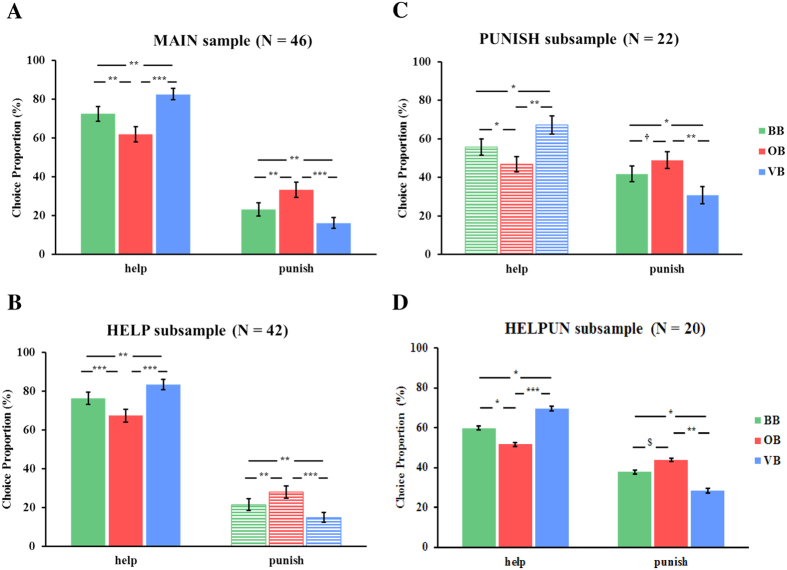
Proportion of altruistic choices in different other-regarding attention conditions.A pairwise comparison between the conditions was performed on help and punishment proportion for (A) the MAIN sample, (B) the HELP subsample, (C) the PUNISH subsample and (D) the HELPUN subsample. BB = baseline block, OB = offender-focused block, VB = victim-focused block; $p < 0.1, †p < 0.05; LSD correction; *p < 0.05, **p < 0.01, ***p < 0.001, Bonferroni correction. Shading patterns indicate the non-relevant decision type for the specific subsample. Error bars represent the SEM.